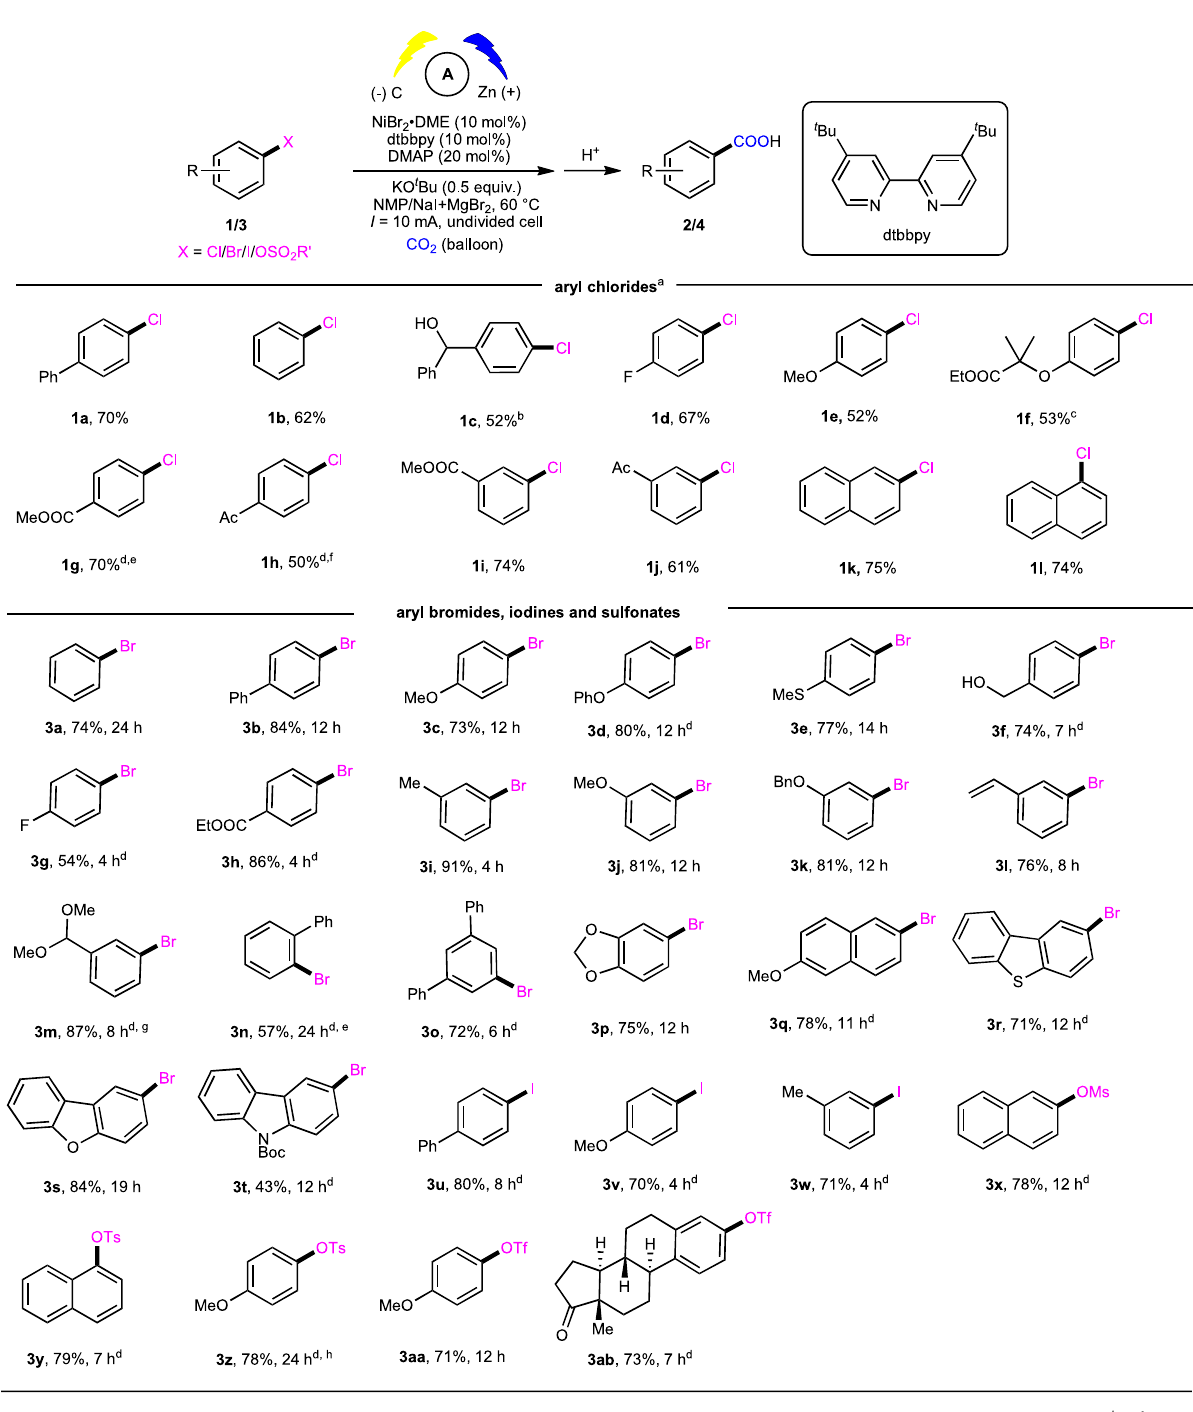
Fig. 2 Scope of aryl chlorides, bromides, iodines, and sulfonates. a Reaction conditions, see more details in “ Supplementary information ” . b 5 Å molecular sieve was added. c NiBr 2 • DME (5 mol%), dtbbpy (5 mol%), DMAP (10 mol%). d Ni(acac) 2 (5 mol%), dtbbpy (5 mol%), KO t Bu (0.5 equiv), I = 8 mA.